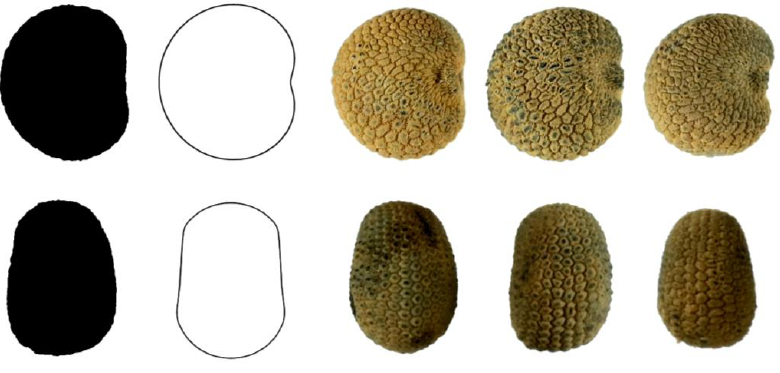
Figure 5. Silene marizii : average silhouettes (left), the models giving best scores with 20 seeds (LM2 and DM2), and three representative images for the lateral (above) and dorsal (below) seed views. Bar represents 1 mm.